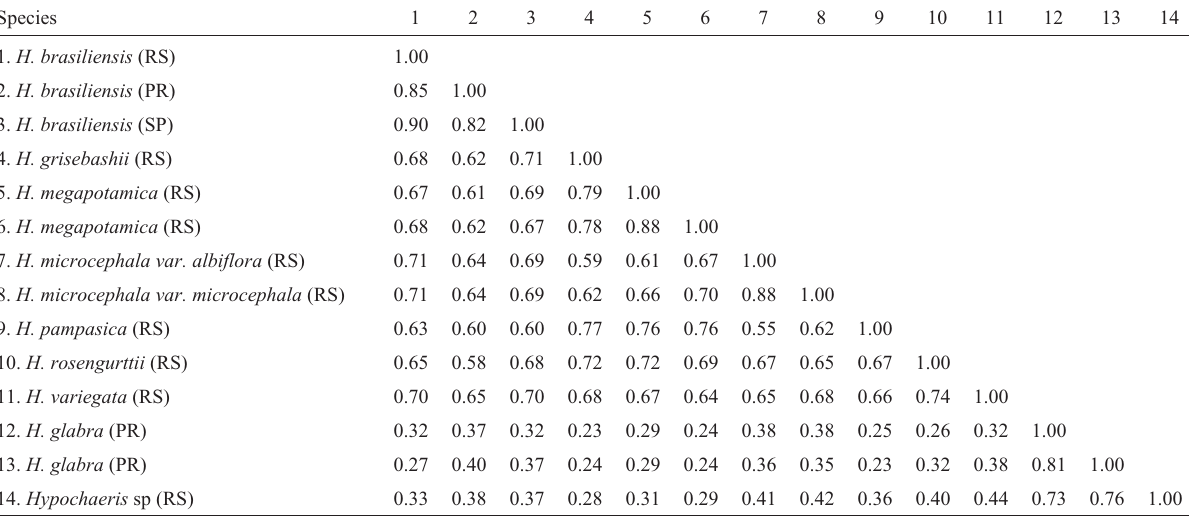
The letters in parenthesis represent Brazilian states as described in Table